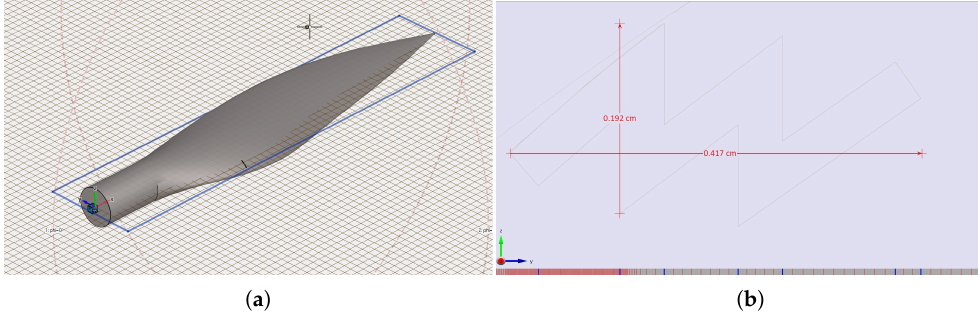
Figure 28. ( a ) The rotor blade with a crack; ( b ) the crack’s shape. By comparing the reflected voltage from the undamaged rotor blade and the rotor blade with a crack, as shown in Figure 29, one can determine if there is a crack.